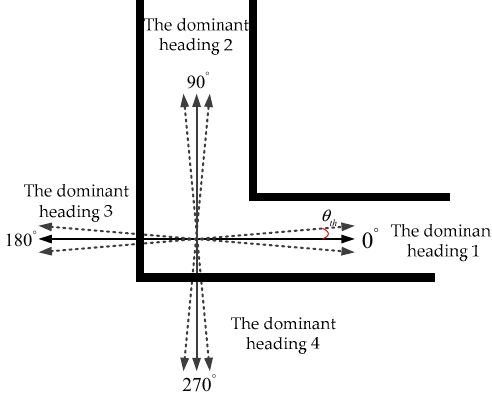
Figure 1. Four dominant directions are pre-established with the fact that most corridors in buildings are straight and so are most walls and sidewalks alongside where a person might walk.